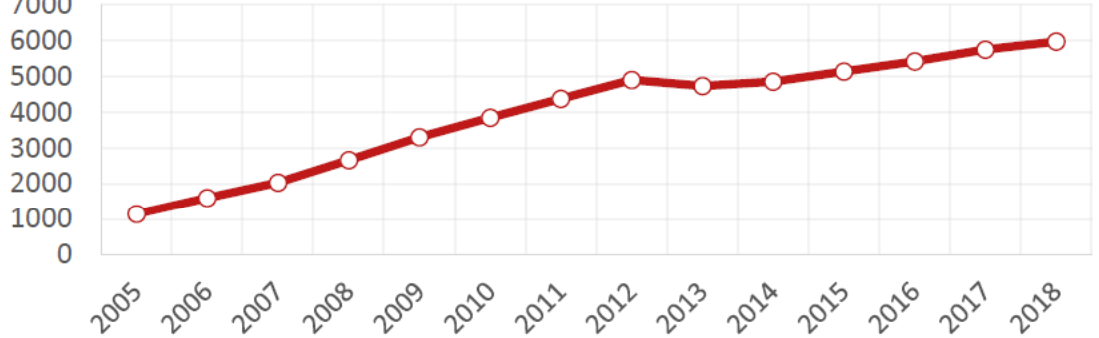
Figure 4: Growth in retained earnings account of METROSTAV (in millions of CZK), (source: Annual report of METROSTAV 2014-2018, data processed by the authors) Analysis of SKANSKA